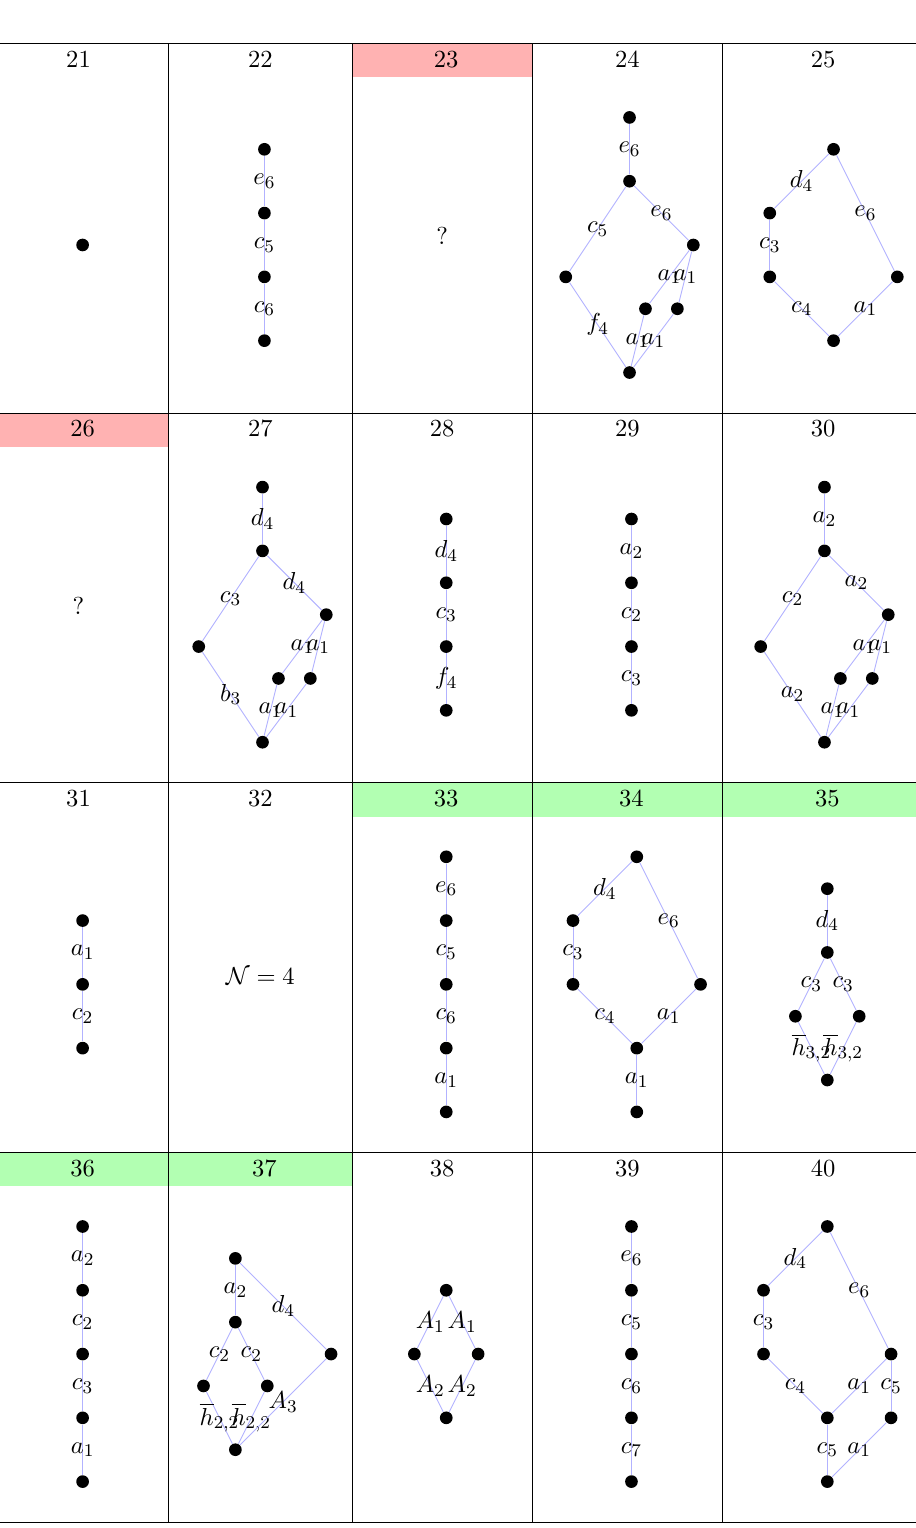
Table 9 . Hasse diagrams deduced from unitary magnetic quivers by quiver subtraction